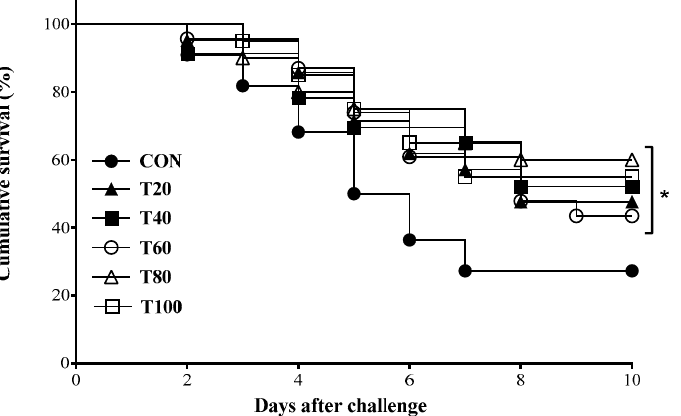
Figure 2. Cumulative survival rate after challenge with Lactococcus garvieae for 10 days in rainbow